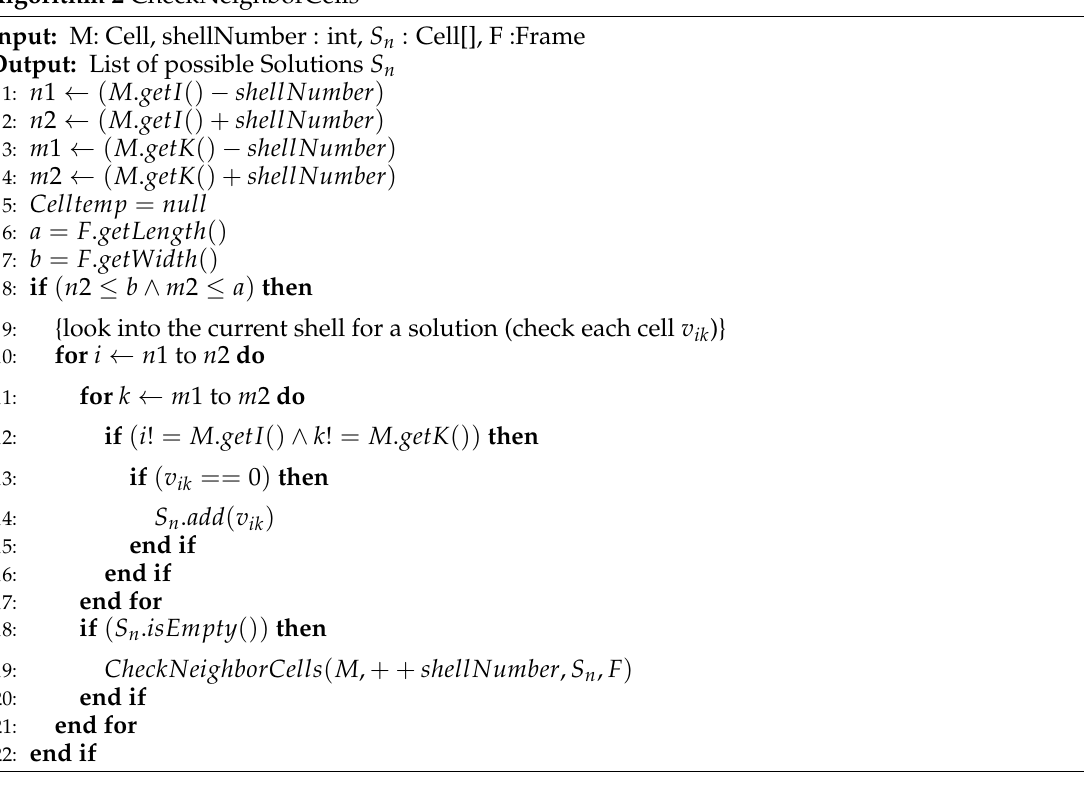
Algorithm 2 CheckNeighborCells